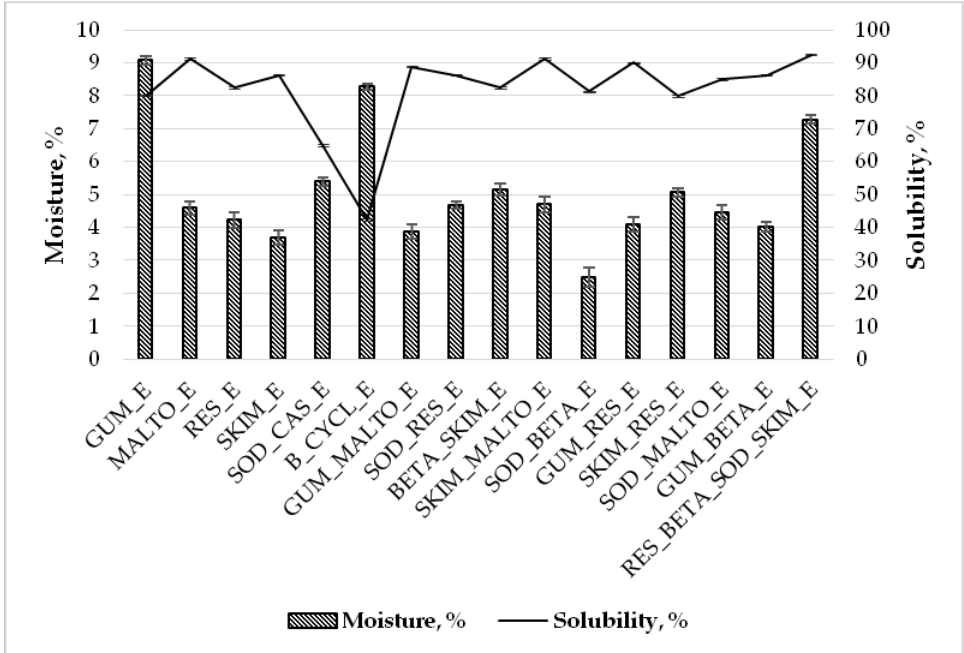
Figure 3. Moisture (%) and solubility (%) of freeze-dried powders obtained using different wall materials